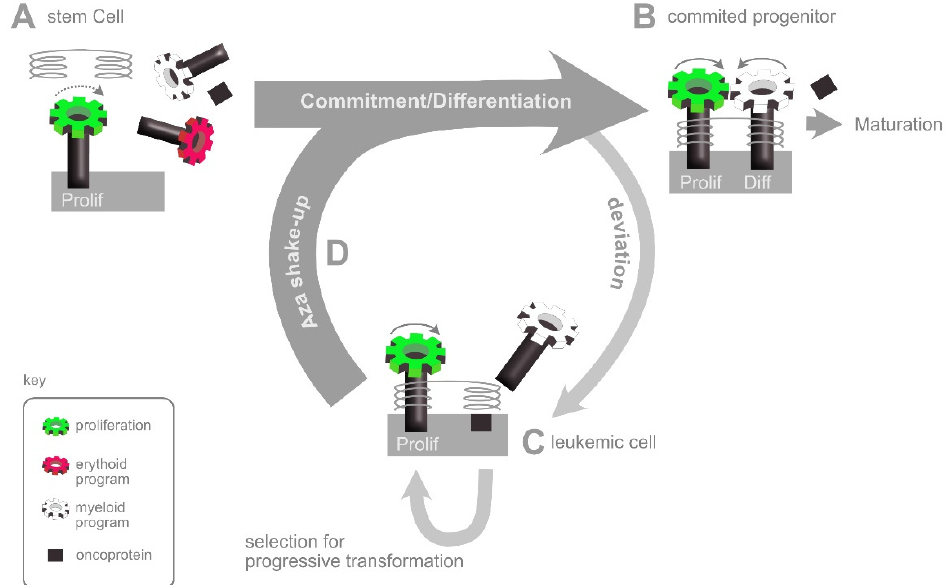
Figure 4. The aza-shake-up. ( A ) A multipotent stem cell maintains the genetic programmes relevant to each potential fate in a primed state in which the chromatin is accessible but gene expression low. Proliferation is slow (dashed arrow) and is not linked to differentiation. ( B ) During lineage commitment, one lineage programme is activated and others silenced. Proliferation is linked to differentiation to limit expansion. ( C ) An oncoprotein interferes with the differentiation programme to disengage proliferation from differentiation. Even if this occurs in only a small proportion of the mutant cells, these can become trapped in a self-renewal loop that provides the basis for amplification and further selection. ( D ) Azanucleoside treatment reactivates (recently) suppressed genes, resulting in an epigenetic shake-up and the chance to settle back into a normal fate.